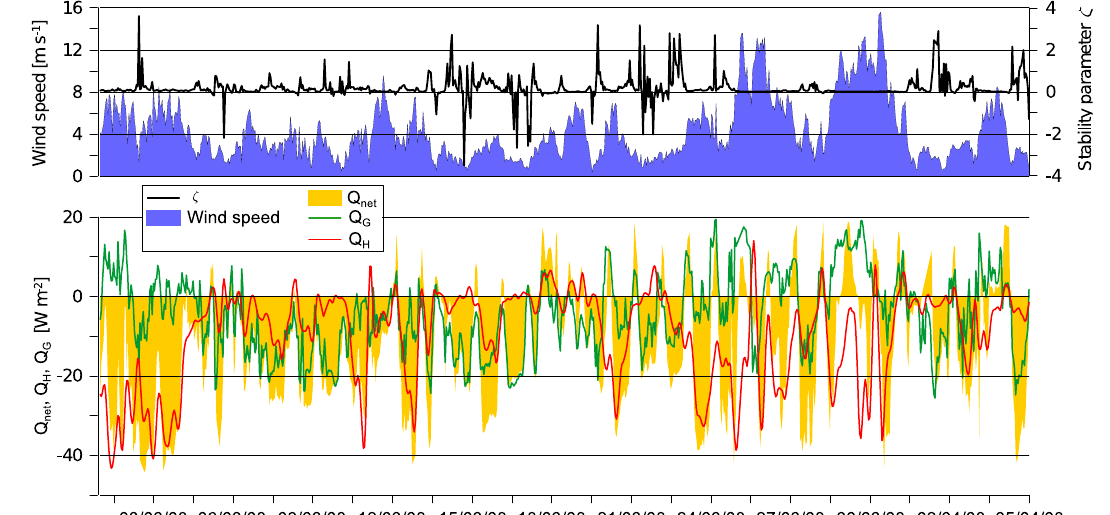
Fig. 8. Hourly averages of Q net , Q H and Q G during the late winter in 2008 (lower graph). The wind speed and the stability parameter ζ are depicted in the upper graph. 5